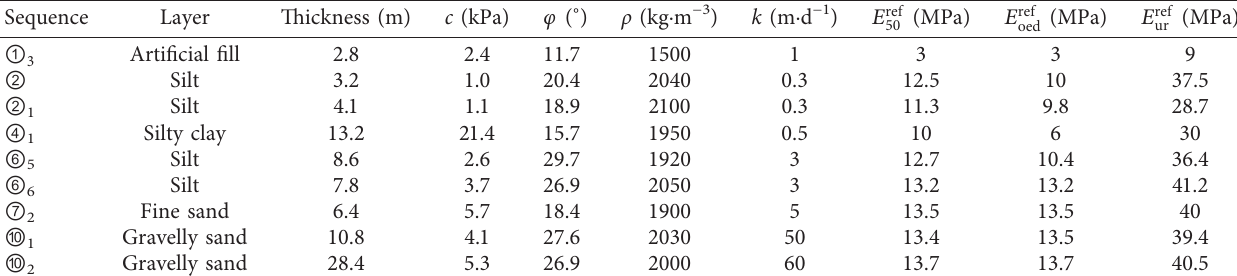
Table 1: Material